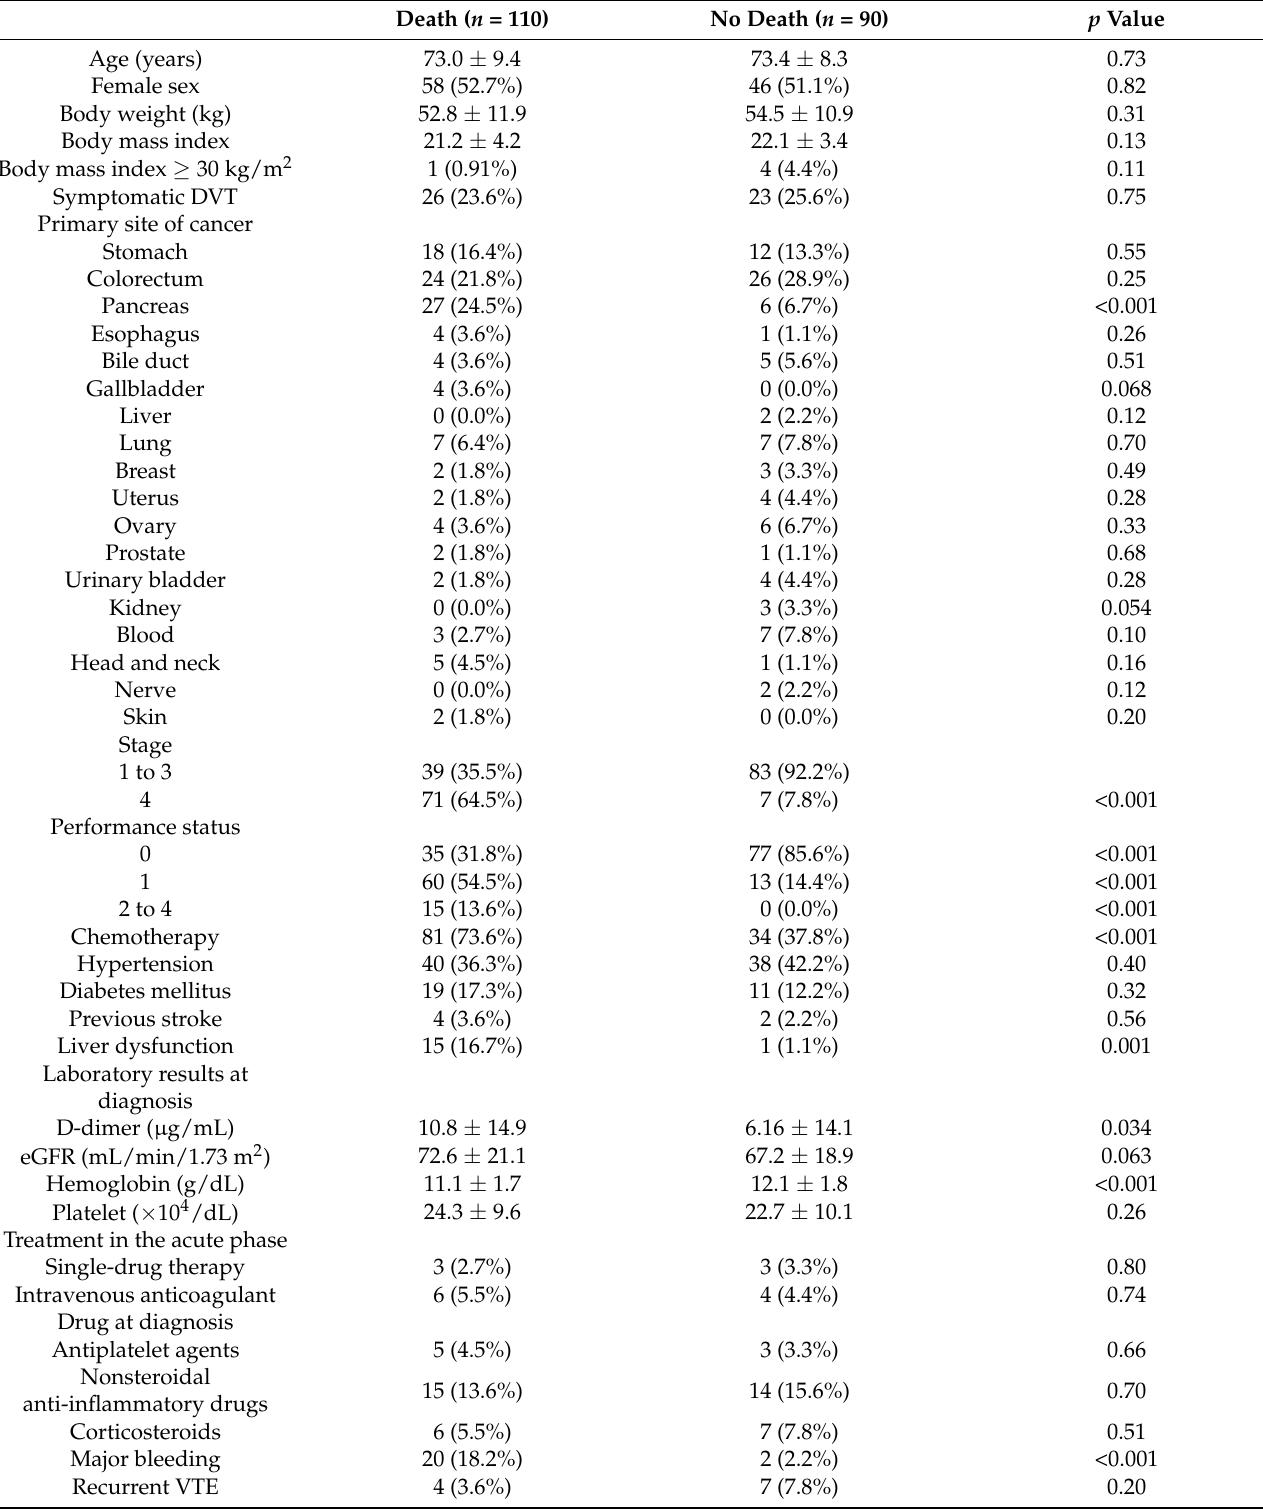
Table 4. Comparison between patients with and without death.